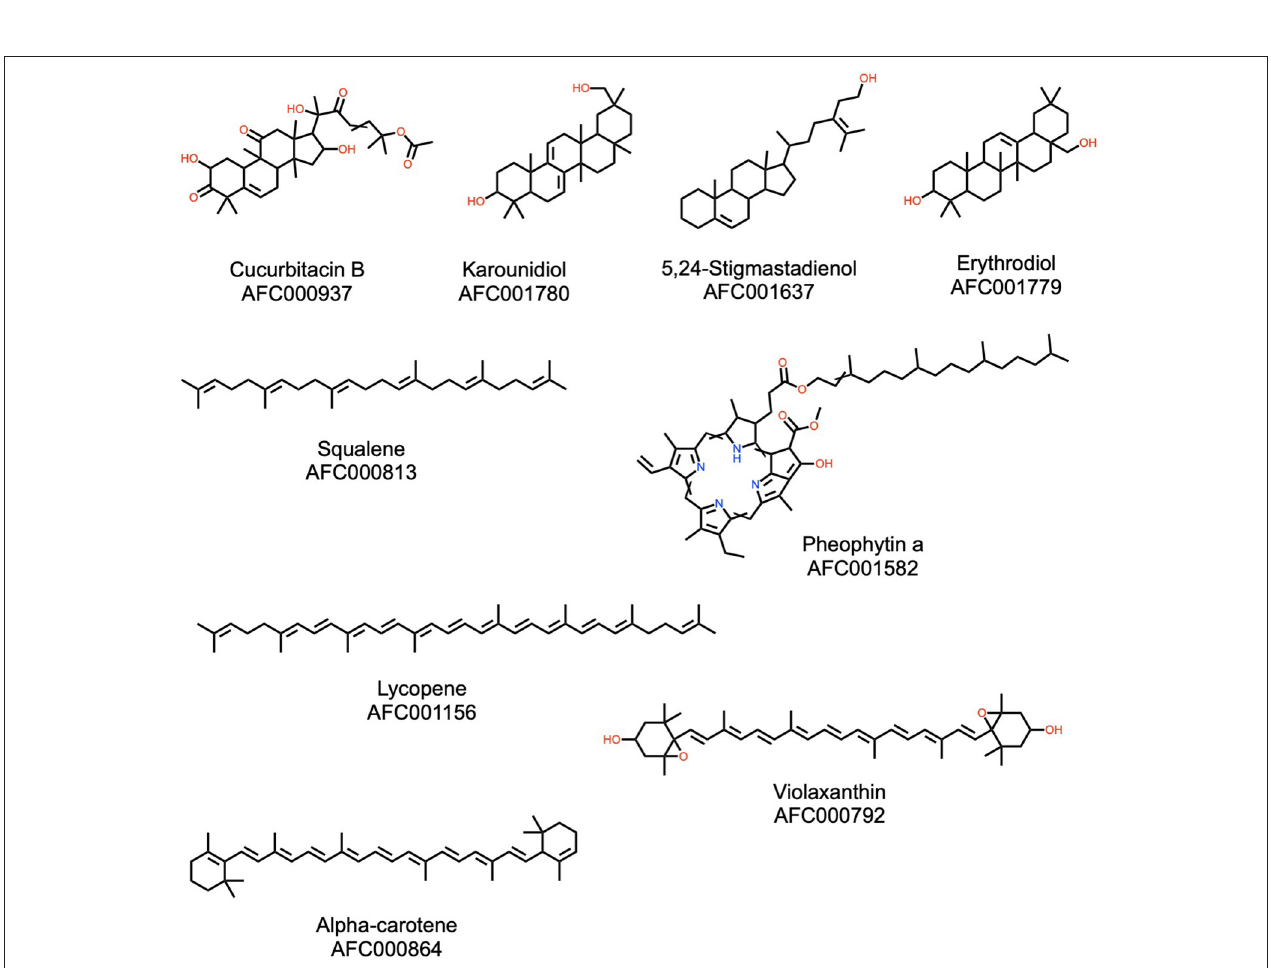
Frontiers in Nutrition |